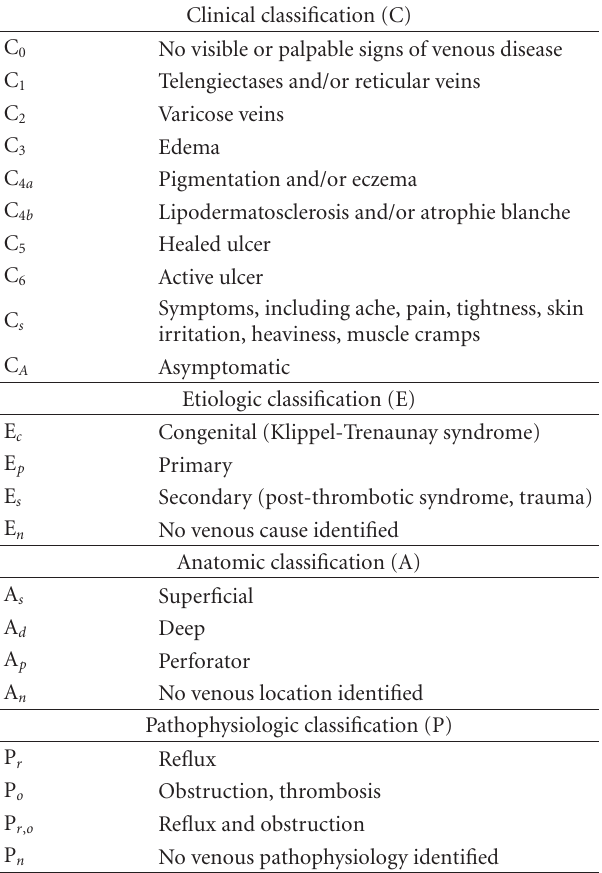
Table 1: The CEAP classification. Clinical classification